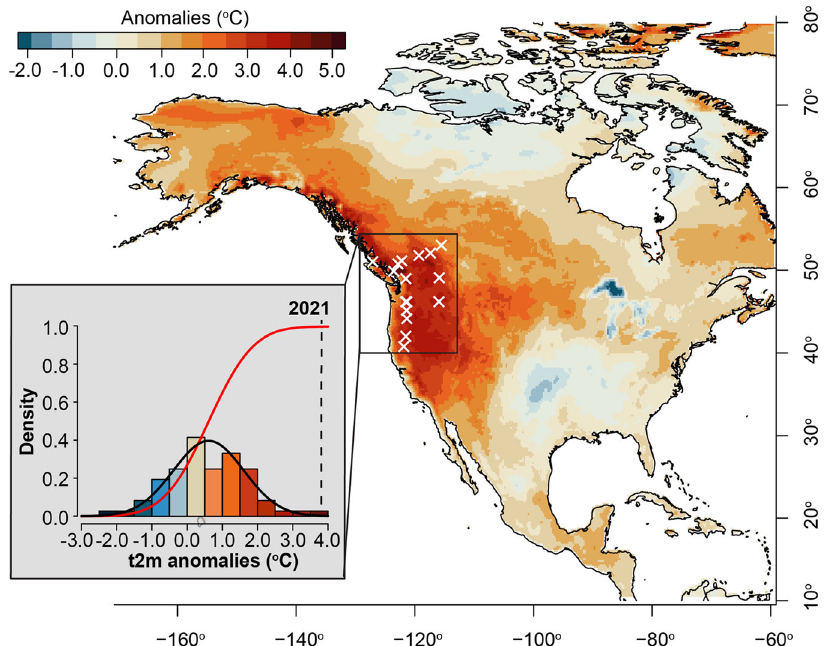
Fig. 1 The physical imprint and consequences of extreme summer heat across the Paci fi c Northwest in 2021. June-August (JJA) 2021 seasonally averaged temperature anomalies (t2m) over North America calculated from the 1951 – 1980 mean of ERA5 Reanalysis, with the Paci fi c Northwest region (PNW; 42 – 53 °N, 124 – 115 °W, dark blue box) highlighted. The year 2021 (dashed black line) is shown relative to the distribution (black line) and probability density (red line) curves of JJA t2m values over the period 1950 – 2021 for the PNW region. White exes indicate the locations of all tree-ring chronology predictors used in the subsequent JJA t2m